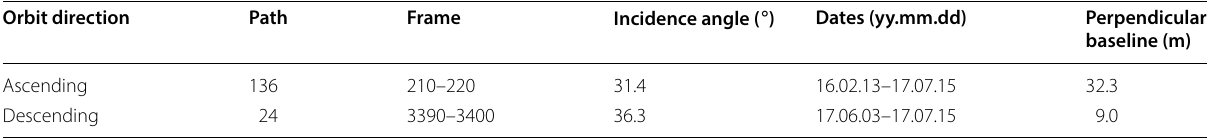
Table 2 ALOS-2/PALSAR-2 data used for computing the interferograms of the 2017 earthquake Orbit direction Path Frame Dates